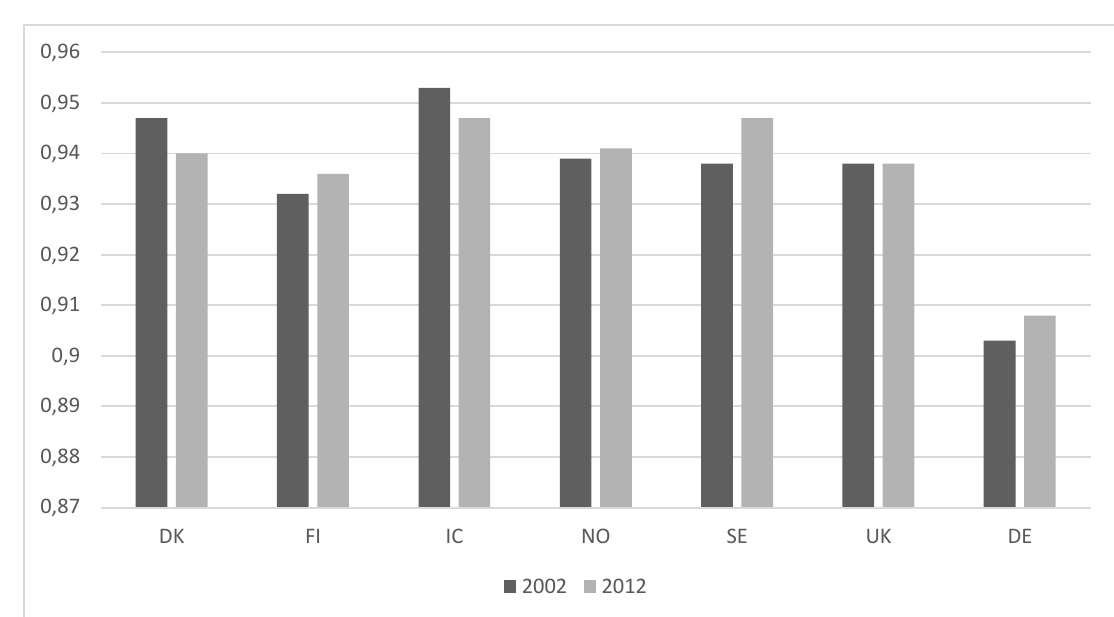
Figure 1: Mean health on a 0–1 scale, based on self-assessed health with health categories weighted by TTO weights. The Nordic countries, UK and Germany, 2002 and 2012